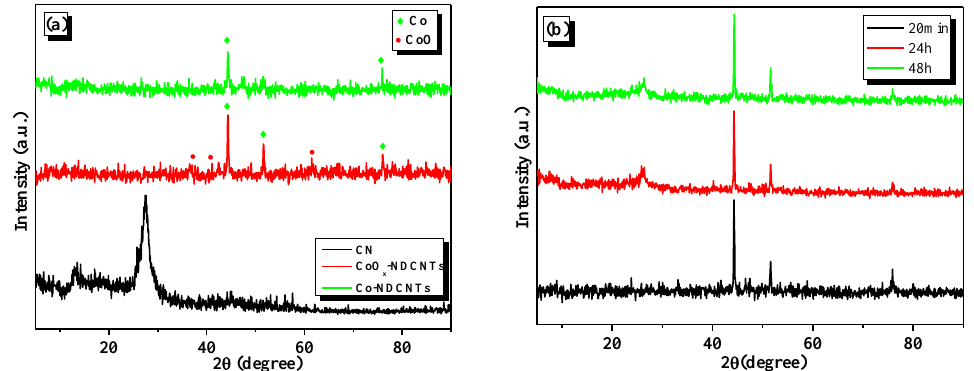
Figure 2. ( a ) The powder X-ray di ff raction (XRD) patterns for g-C 3 N 4 , CoO x –NDCNTs, Co–NDCNTs and ( b ) the powder XRD patterns of di ff erent acid treatment time.